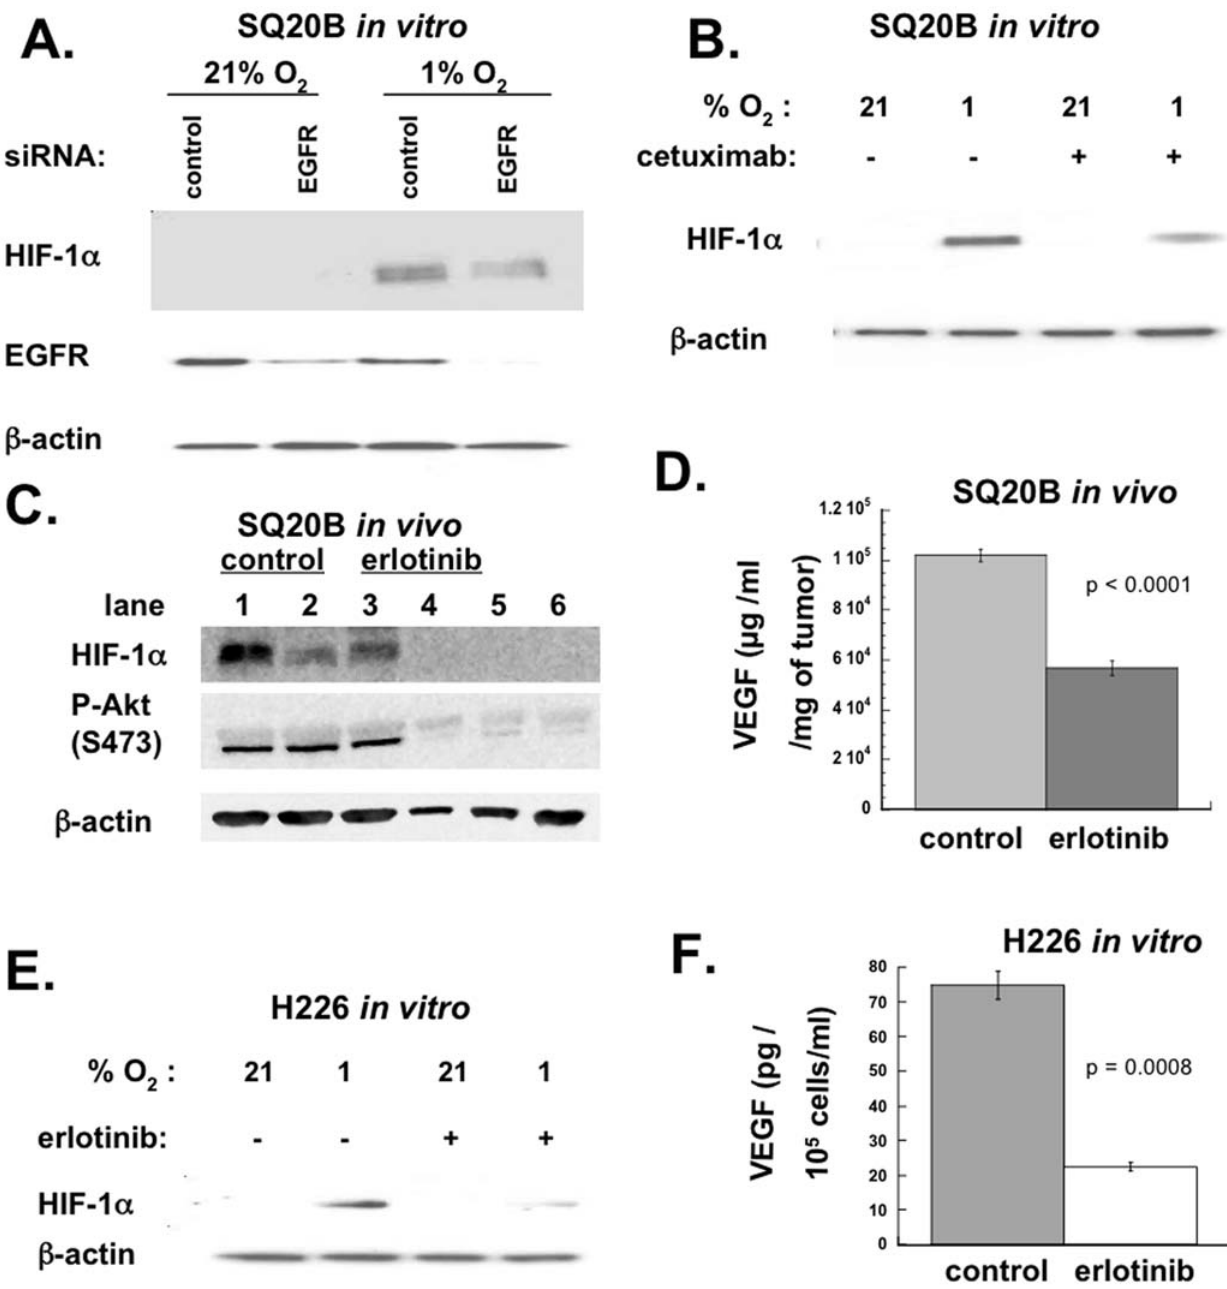
Figure 1. EGFR inhibition downregulates VEGF and HIF-1 invitro and invivo . SQ20B cells were seeded at 25% confluence and cultured overnight. The next morning, cells were transfected with 150 nanomoles siRNA (either EGFR SmartPool or control non-targeted) in Optimem transfection medium using Oligofectamine. After 24 hours, the transfection medium was replaced with fresh, prewarmed culture medium. 24 hours after this (48 hours after transfection), cells were exposed to either 21% or 1% oxygen. Three hours later they were harvested and Western blotting was performed. (B) SQ20B cells were treated with 10 nM cetuximab or DMSO (control) for 16 hrs, and then exposed to either 21% or 1% oxygen. Three hours later they were harvested and Western blotting was performed. (C) Nude mice were injected subcutaneously in the flank with SQ20B cells to form xenografts. When the tumors reached a size of 100–150 mm 3 (approximately 7–10 days after injection), half the mice (lanes 4–6) were started on an erlotinib-containing diet (50 mg/kg/day). After 4 days of feeding, mice were sacrificed, and the tumors were removed. Half of each tumor was lysed in protein lysis buffer, and Western blotting was performed for pAkt (S473) and HIF-1 a . Each lane represents a tumor from a different mouse. (D) The other half of each tumor from (E) was homogenized in PBS, and then ELISA for VEGF was performed. VEGF level was normalized to tumor weights. Data shown represent mean values from 3 control mice and 3 erlotinib-treated mice. Error bars represent standard error of the mean. p value was obtained using Student’s t-test. (E) H226 cells were treated with 10 m M erlotinib or DMSO (control) for 16 hrs, and then exposed to either 21% or 1% oxygen. Three hours later they were harvested and Western blotting was performed. (F) H226 cells were seeded then later that day they were treated with erlotinib (10 m M) or DMSO (control). 24 hours later, the media was changed and replaced with media containing 1% serum with or without erlotinib. Cells were exposed to 1% oxygen. 16 hours later, aliquots of supernatant were removed from dishes, and ELISA for VEGF was performed. ELISA values were normalized to the number of cells present. Data shown represent mean values. Error bars represent standard error of the mean. p value was obtained using Student’s t-test.